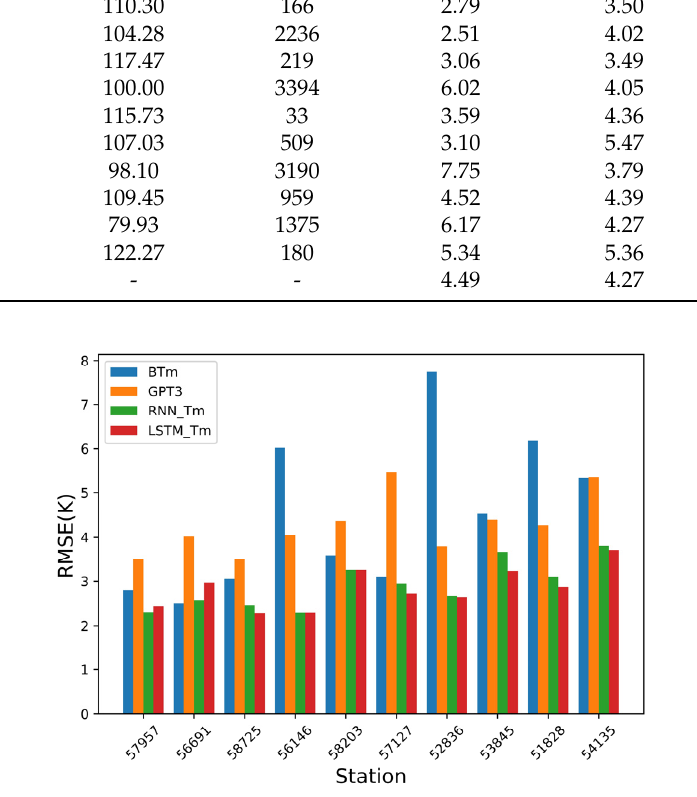
Figure 9. RMSEs of different models at 10 stations (K).